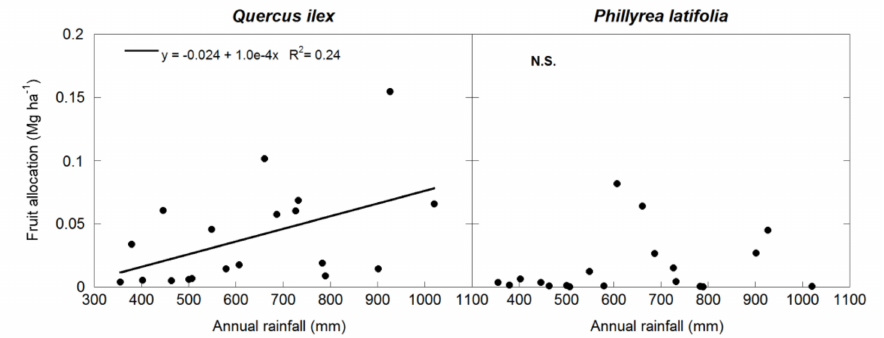
Figure 3. Linear relationships between fruit allocation and annual rainfall in the two dominant species of the studied